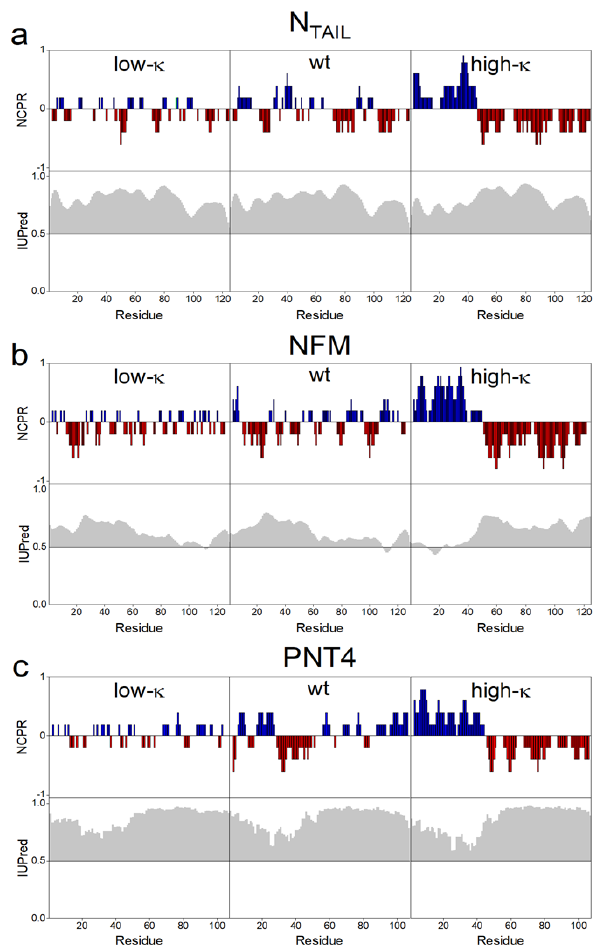
Figure 2. Comparative bioinformatic analyses of N TAIL ( a ), NFM ( b ) and PNT4 ( c ). Upper panels: The FCR , fraction of charged residues, was calculated by CIDER [32]. Each model protein contains charged residues at high density, with red and blue bars indicating negative and positive charges, respectively. The increase in κ value is reflected in the progressively more “blocky” distribution of charged residues. Lower panel: each protein is predicted to be predominantly disordered by IUPred [33]. The discrepancy from the disorder threshold value (0.5) in the IUPred score is shaded in gray. The IUPred and CIDER outputs were generated using the default options of the respective web